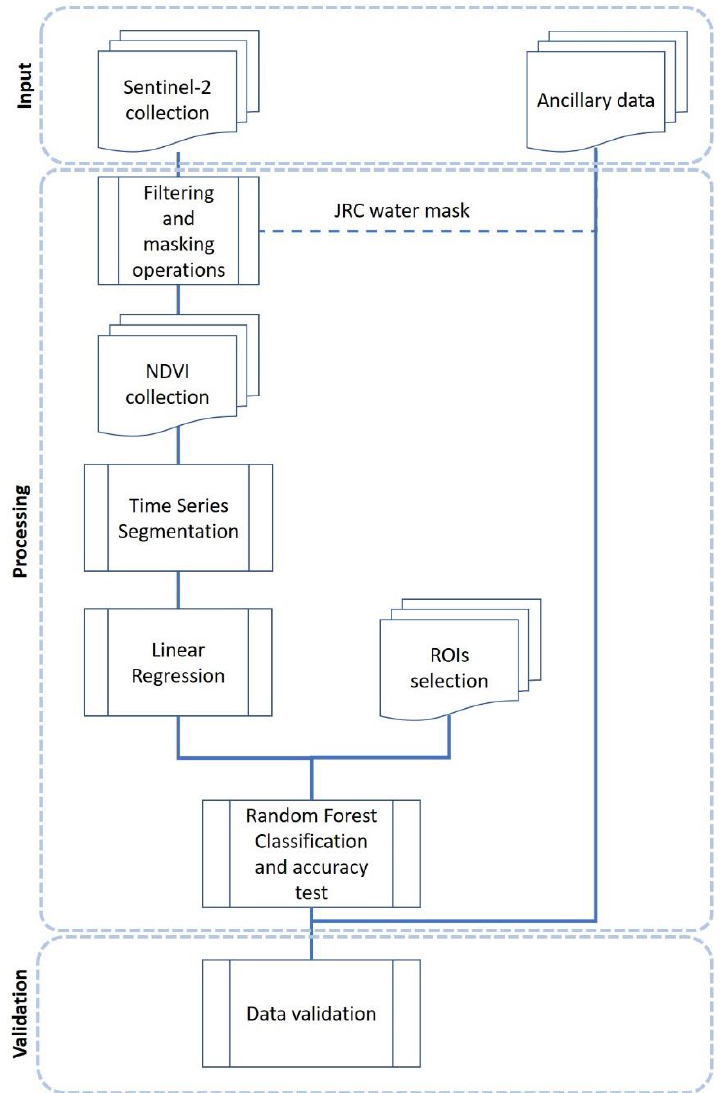
Figure 2. Figure 2. Flowchart.